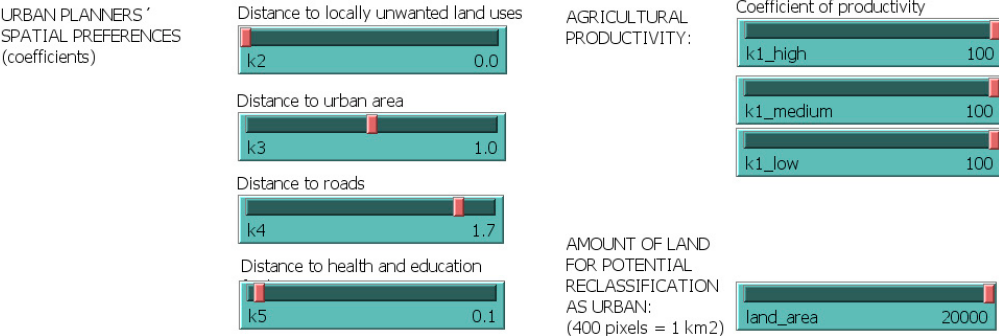
Figure 5. Variables that can be set when initializing the model to define different urban planner profiles.